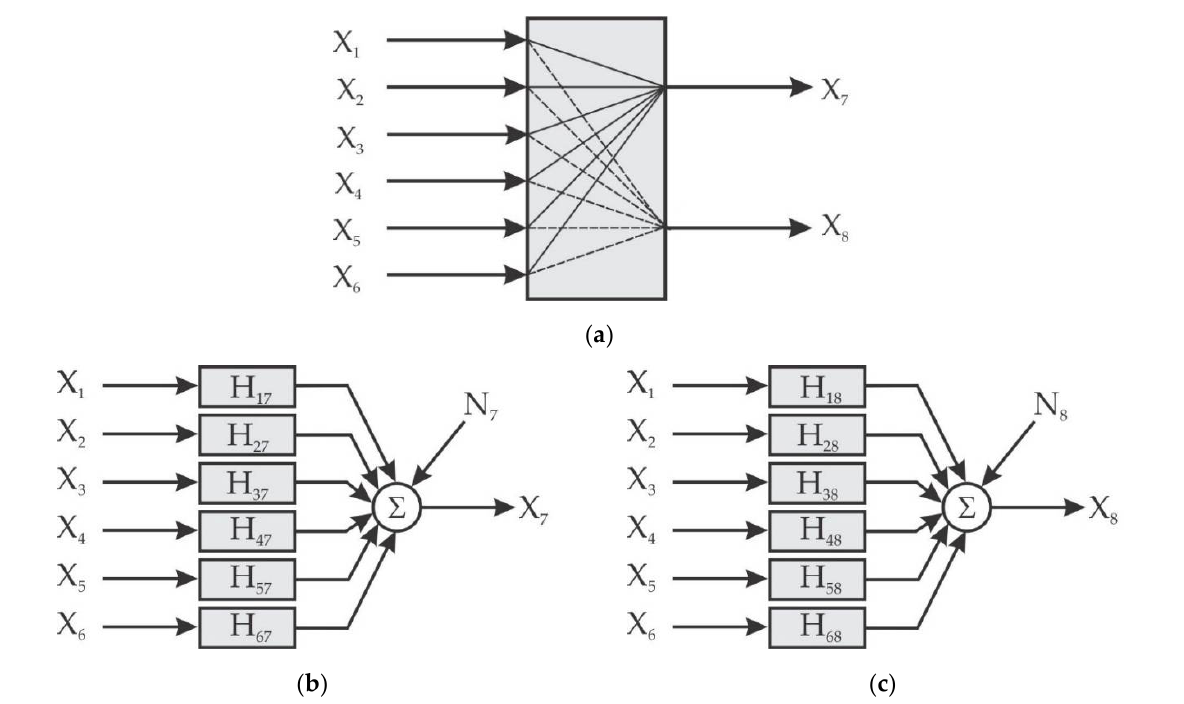
Figure 6. Structure of the vehicle dynamic system model with six arbitrary inputs and two outputs. ( a ) General model of the system; ( b ) equivalent multiple input/single output model for the output X 7 ; ( c ) equivalent multiple input/single output model for the output X 8